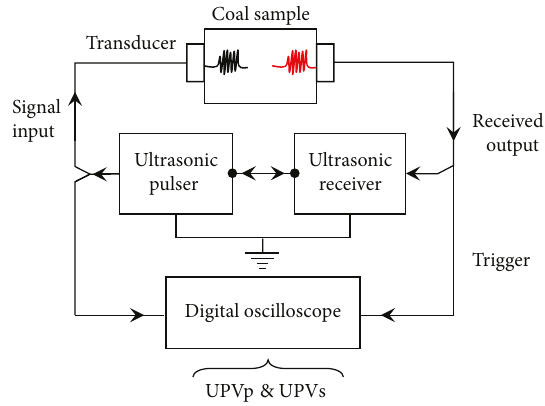
Figure 1: Schematic diagram of the UPV device used in this